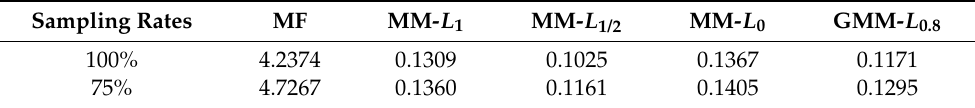
Figure 10. The imaging results of real complex target SAR data corresponding to the 75% sampling rate. ( a ) The MF result. ( b ) The MM- L 1 result. ( c ) The MM- L 1/2 result. ( d ) The MM- L 0 result. ( e ) The GMM- L 0.8 result. Table 8. The ENT of the SAR Data of the Complex